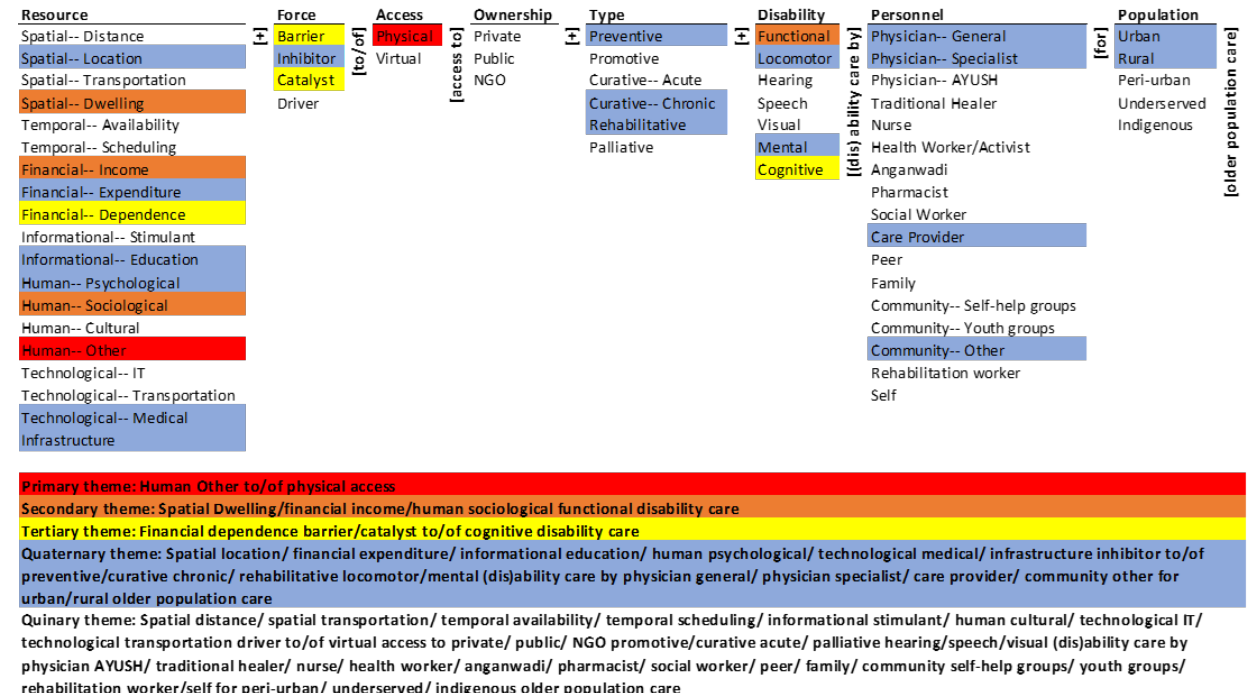
Figure 3. Monad map of access to geriatric disability care.